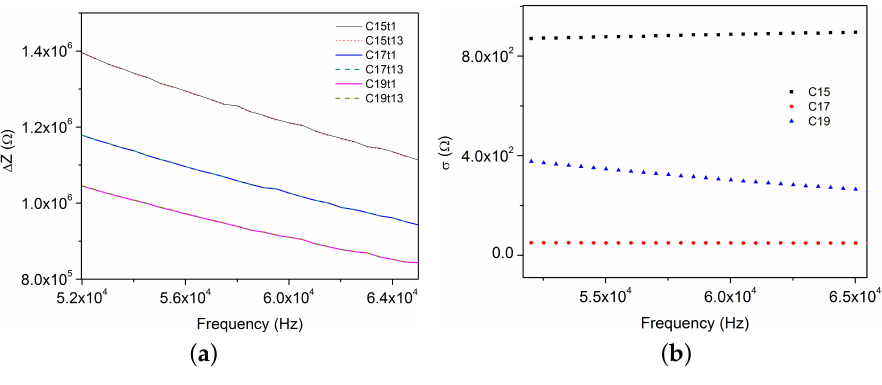
Figure 13. ∆ Z vs. Frequency ( a ) Time and ( b ) Standard deviation ( σ ): C15—0.50%, C17—1.50%, and